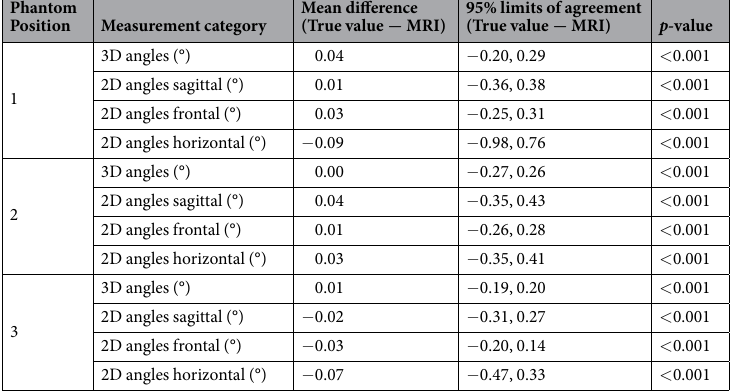
Table 1. Accuracy of angular phantom measurements. All given values refer to 24 different angles per measurement category. p-values < 0.05 indicate equivalence between true values and MRI measurements (two one-sided tests with an equivalence margin of ± 0.5°).